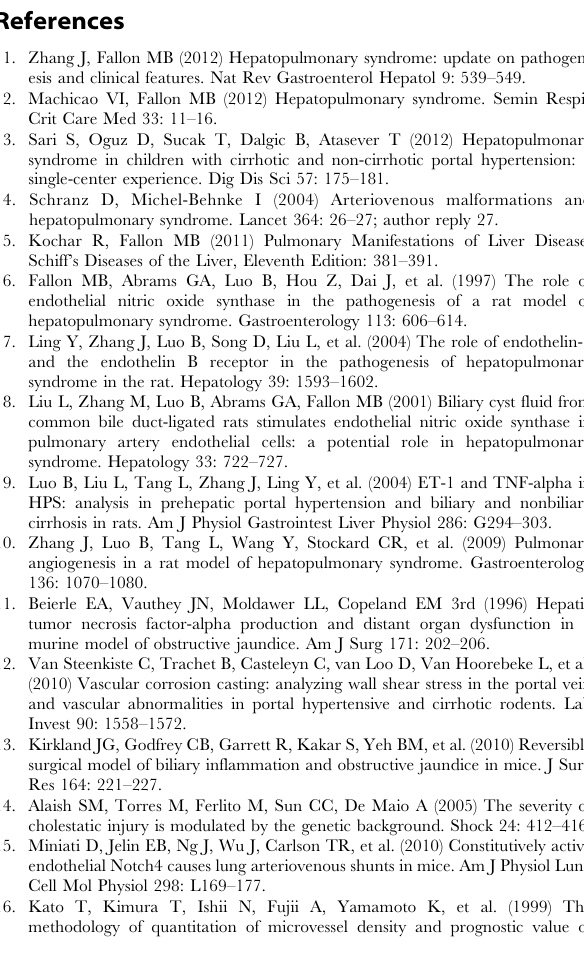
Figure S1 List of proteins in serum of common bile duct ligated (CBDL) mice and sham operated (control) mice in protein array